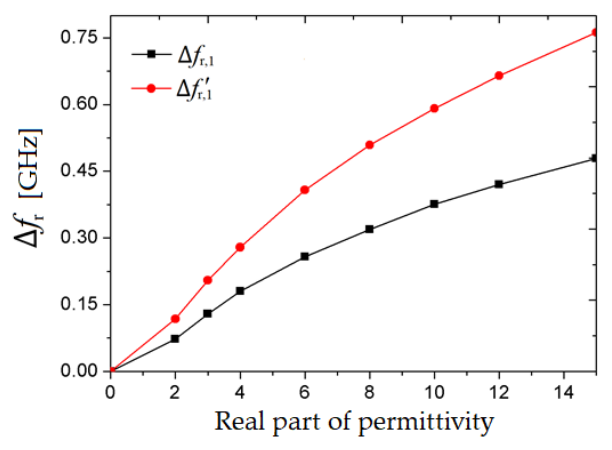
Figure 6. The sensitivity for both resonant frequencies, f r,1 and f ʹ r,1.